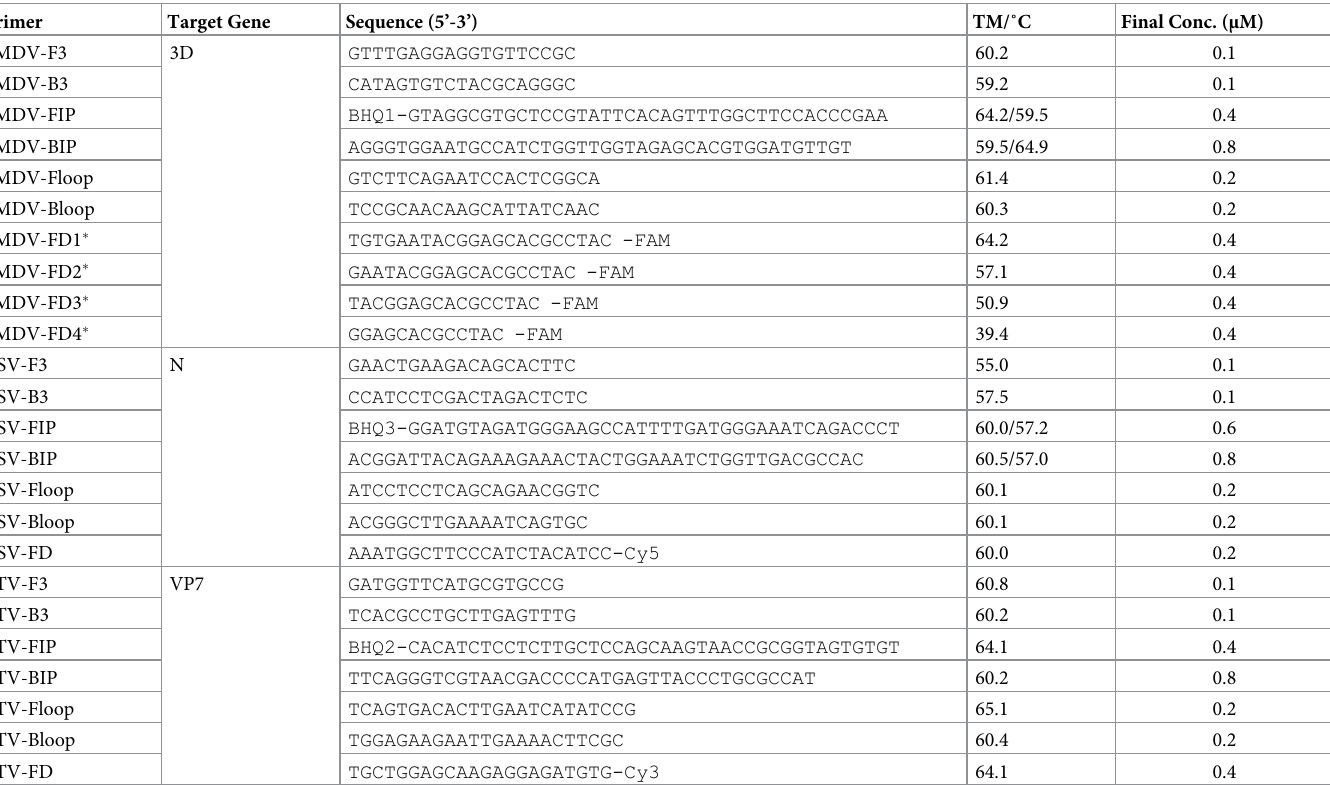
Table 2. Primer and FD probe sequences for the mLAMP reaction.